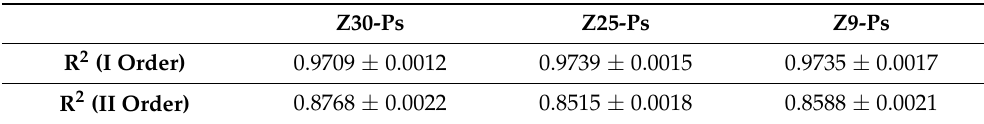
Table 1. Comparison between the R 2 obtained from the first- and second-order fittings with different particle sizes of ZnO. The values confirm a first-order equation better supports the experimental data. p < 0.001 for Z30-Ps and Z25-Ps; 0.01< p <0.05 for Z9-Ps.